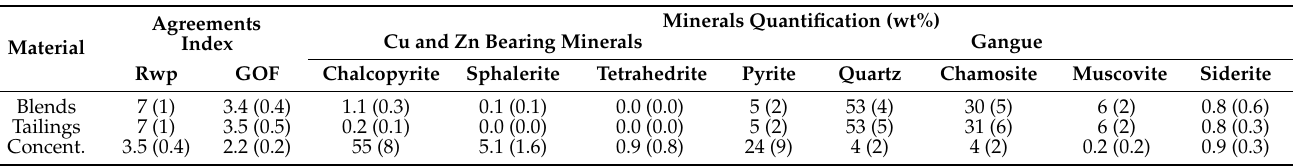
Table 2. Average weight percentages of major minerals as determined by Rietveld refinements. The mineral variability within the same material type is reported as the absolute standard deviation (1 σ ) in between